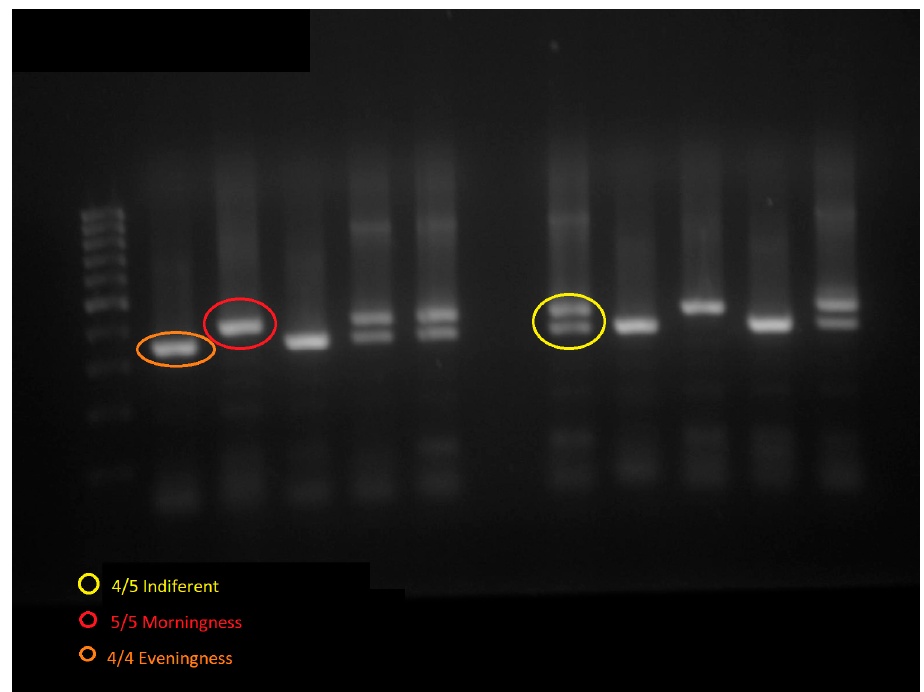
Figure 2. Image from the electrophoresis gel. PCR products corresponding to PER3 4/4 (evening), PER3 5/5 (morning), and PER3 4/5 (intermediate) chronotypes.